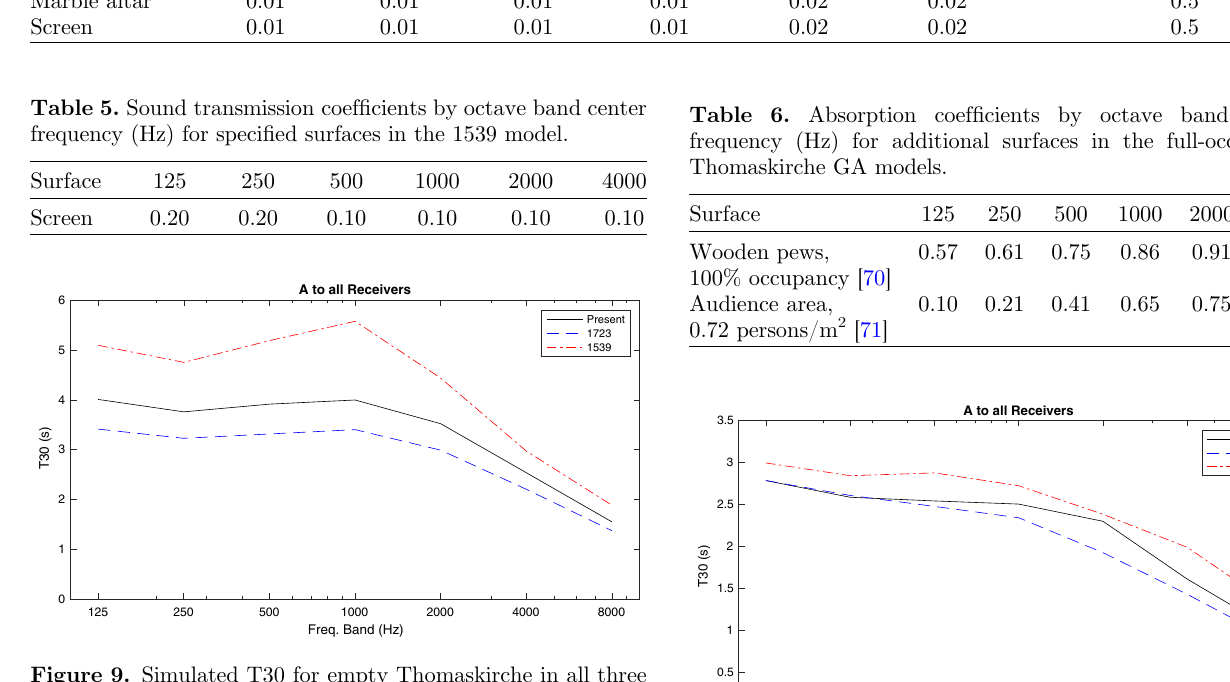
Figure 9. Simulated T30 for empty Thomaskirche in all three eras, from source A, spatially averaged.